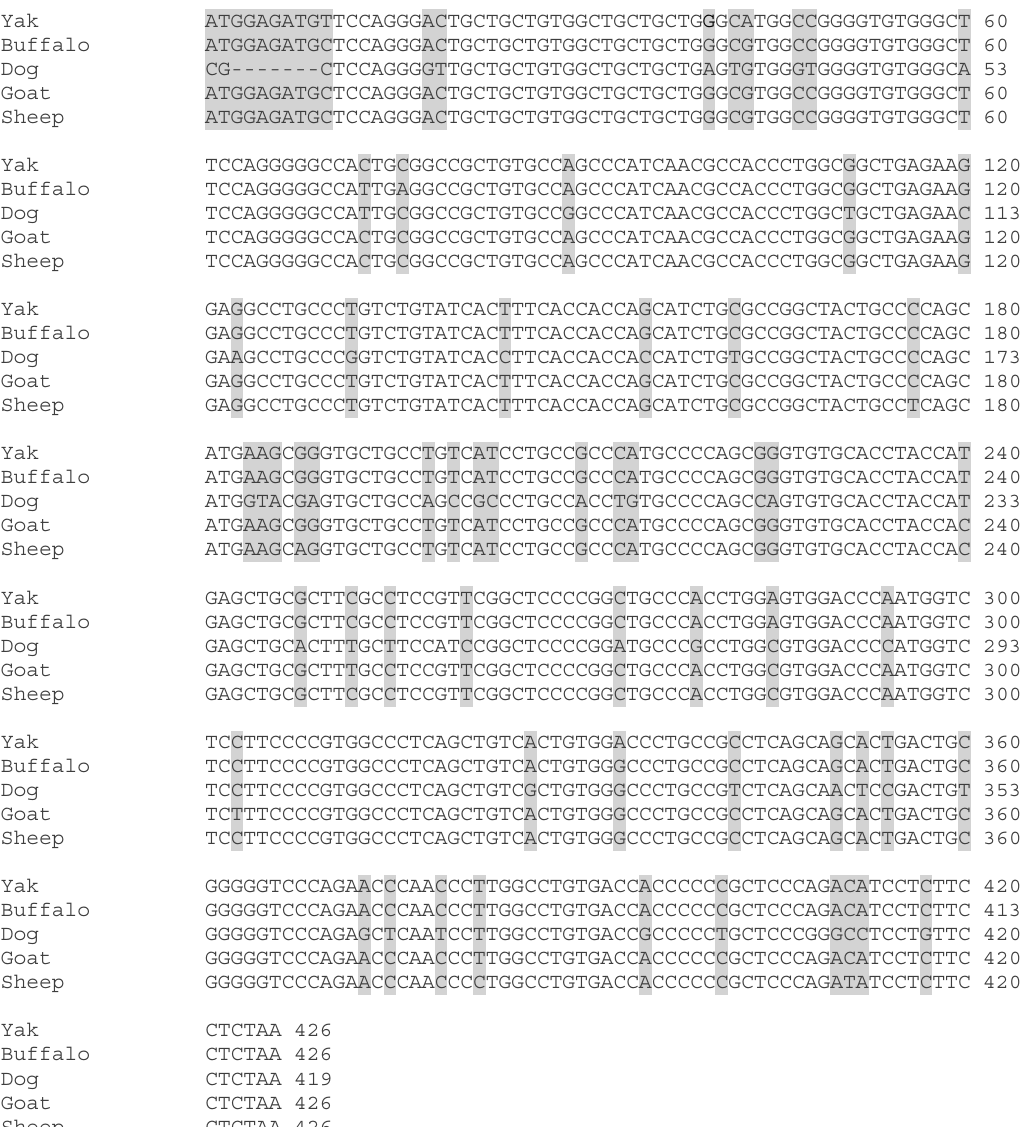
Figure 5. Multiple alignment of the full length sequence of LHB in different animals. Different amino acids are characterized by shaded boxes.